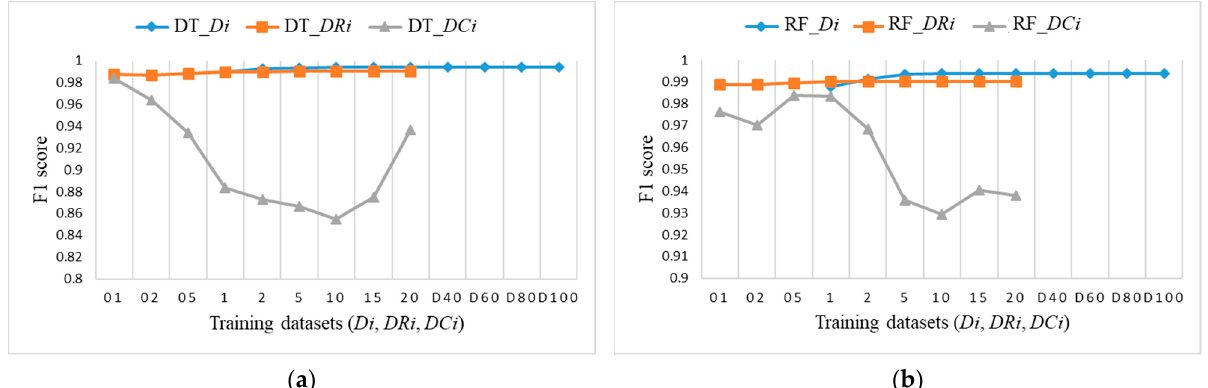
Figure 18. F1 score on test dataset for training datasets Di , DRi , DCi : ( a ) DT; ( b ) RF.